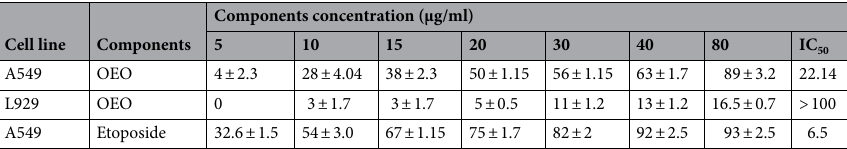
Table 6. Cell inhibition percentage after treatment with OEO and Etoposide for 24 h. Growth inhibition percentage and IC 50 (the concentration of OEO or Etoposide at which 50% of cell proliferation are inhibited) were determined using the MTT assay. The results are the means ± SDs from triplex experiments by the Tukey test at ( p <